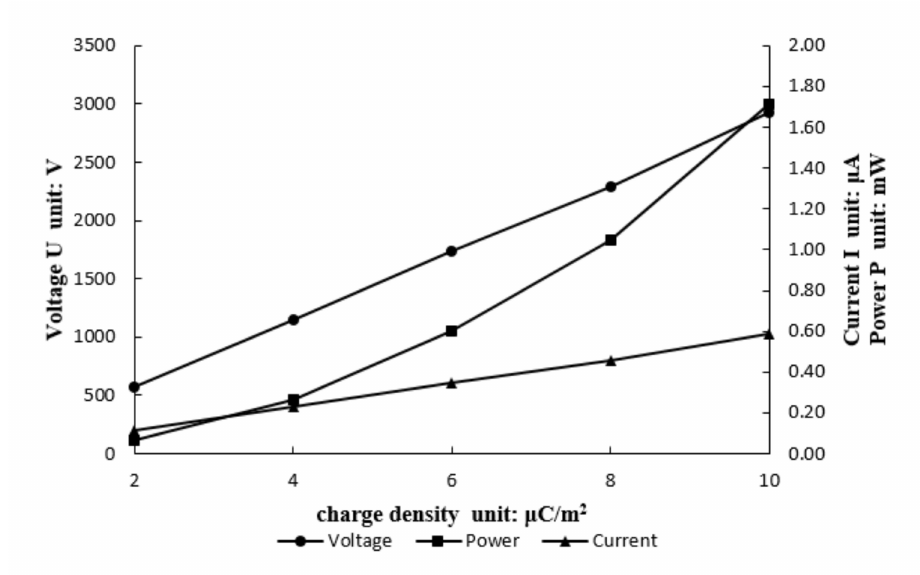
Figure 9. Peak power, current and voltage vary with charge